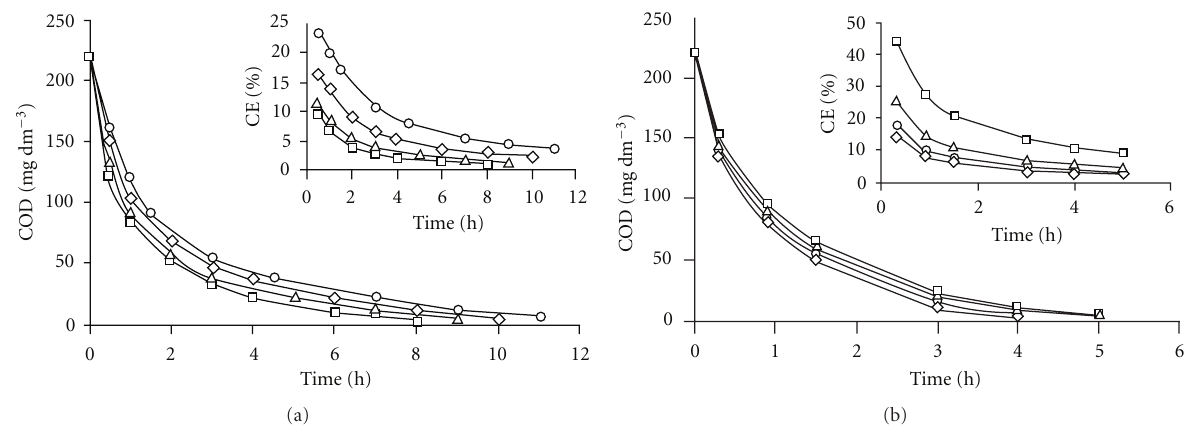
Figure 5: Influence of the applied current on the evolution of the COD and current e ffi ciency (inset) as a function of time during the electrolysis of methyl red on the (a) PbO 2 and (b) BDD anodes, respectively. Flow rate = 180 dm 3 h − 1 ; pH = 3; applied current = ( (cid:2) ) 0.5, ( ♦ ) 1, ( (cid:5) ) 1.5, ( (cid:3) ) 2A [23].